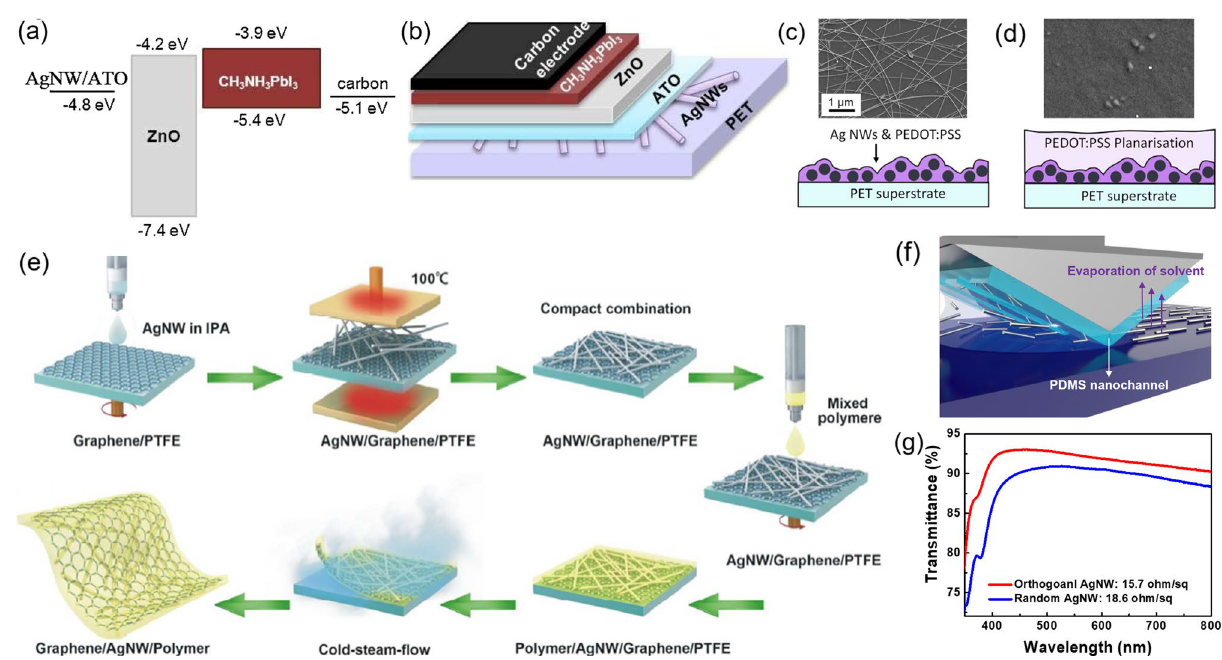
Fig. 4 a Energy level diagram and b device structure of FPSCs based on PET/AgNWs/ATO substrate and carbon back electrode. Reproduced with permission from Ref. [41]. Copyright 2020, Elsevier. SEM images and schematic diagrams of different AgNWs/PEDOT:PSS compos- ite electrodes c without and d with planarization layer. Reproduced with permission from Ref. [108]. Copyright 2017, John Wiley and Sons. e Schematic illustration of the procedures in fabricating composite PET/graphene/AgNWs electrode. Reproduced with permission from Ref. [110]. Copyright 2016, American Chemical Society. f Schematic of fabricating orthogonal AgNWs via capillary printing and g the optical trans- mittance of orthogonal AgNWs/glass compared with random AgNWs/glass. f Reproduced with permission from Ref. [118]. Copyright 2015, American Chemical Society. g Reproduced with permission from Ref. [8]. Copyright 2019, Royal Society of